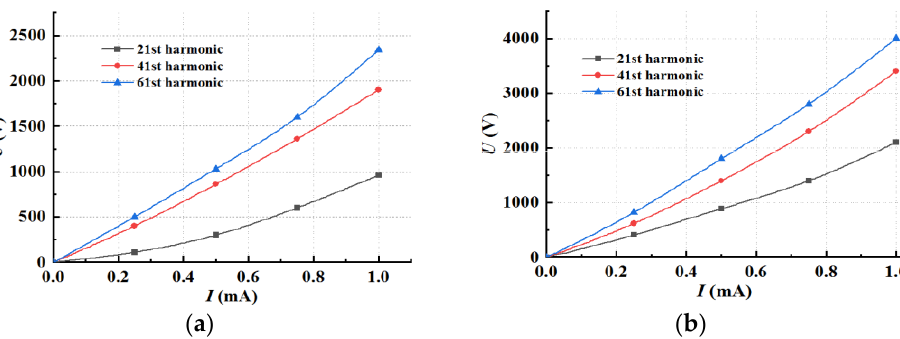
Figure 4. I-U characteristics of the two kinds of valve plate. ( a ) I-U characteristics of ordinary plate; ( b ) I-U characteristics of high-gradient plate